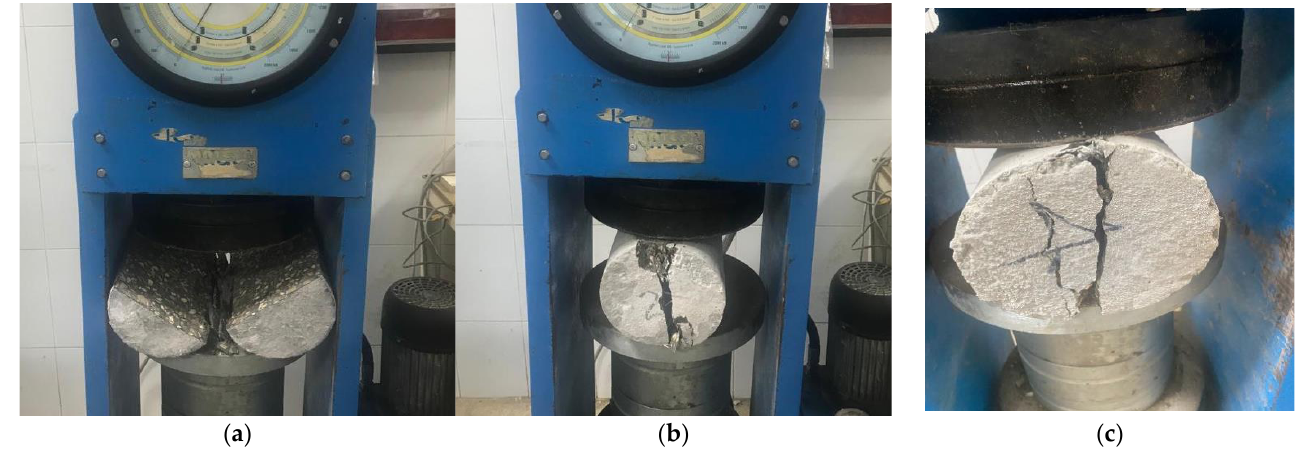
Figure 7. Typical tensile failure modes at room temperature for ( a ) Control specimen, ( b ) Hybrid fiber reinforced concrete specimens, ( c ) Mono fiber reinforced concrete specimens.